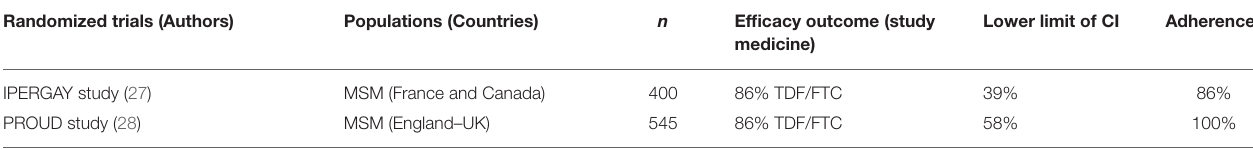
TABLE 2 | Randomized efficacy trials of oral TDF or TDF/FTC combination therapy for pre-exposure prophylaxis–IPERGAY and PROUD. Randomized trials